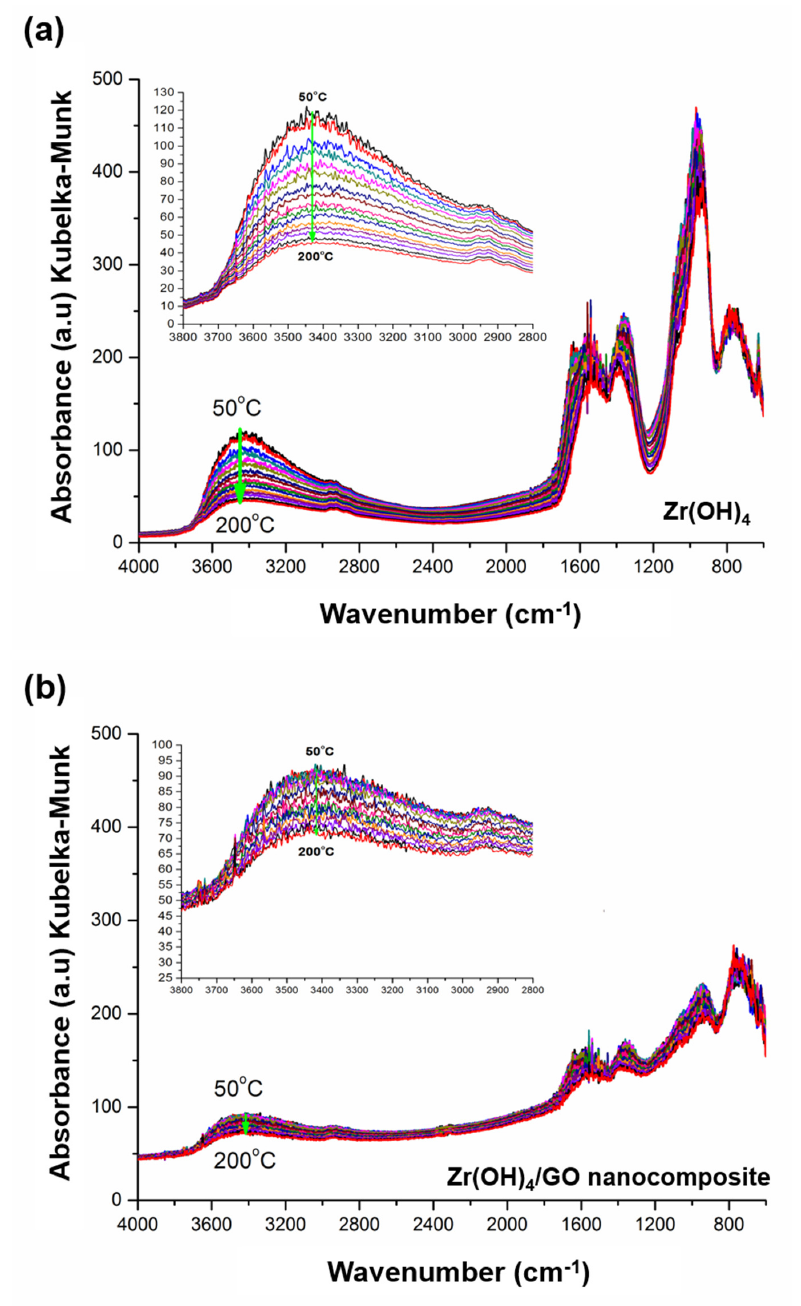
Figure 7. Time-resolved absorbance DRIFT spectra of ( a ) Zr(OH) 4 / GO nanocomposite and ( b ) pristine Zr(OH) 4 . The temperature of the sample cup for DRIFT increased from 50 to 200 °C at a rate of 10 °C / min and was held for 5 min after every 10 °C increase. Spectra were collected every 5